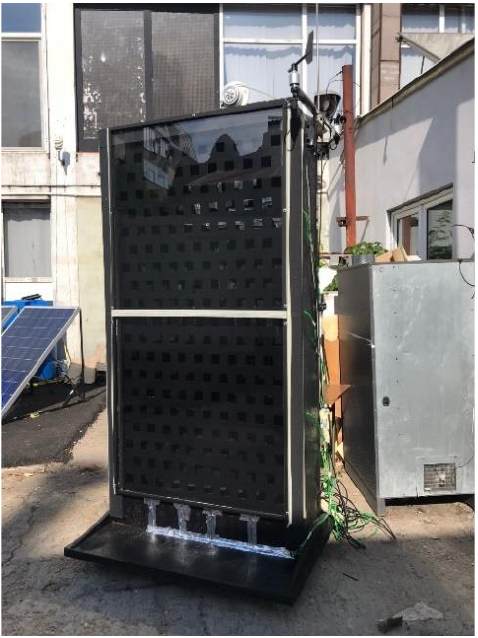
Figure 2. GTC picture with square perforations on the absorber plate.